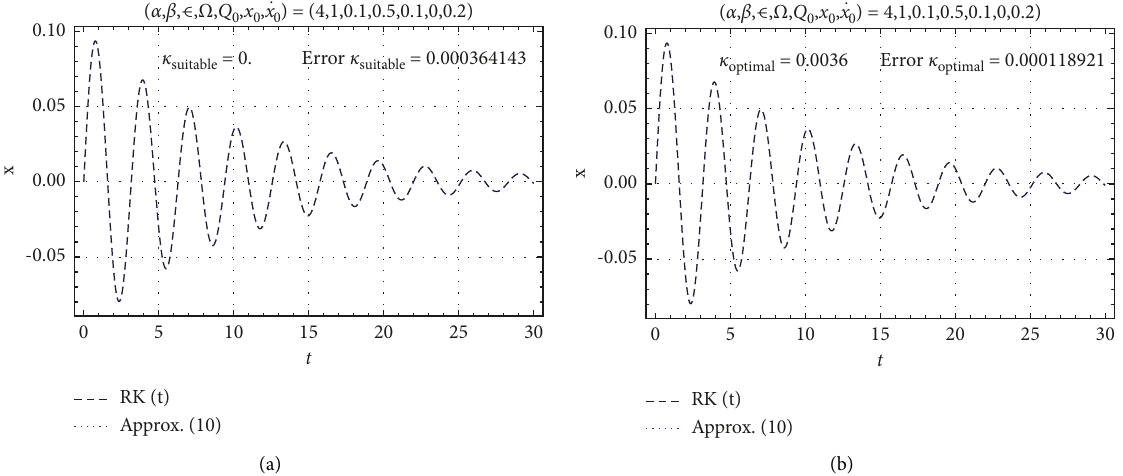
suitable (given in equation (15)) and κ optimal (given in (18)) is plotted